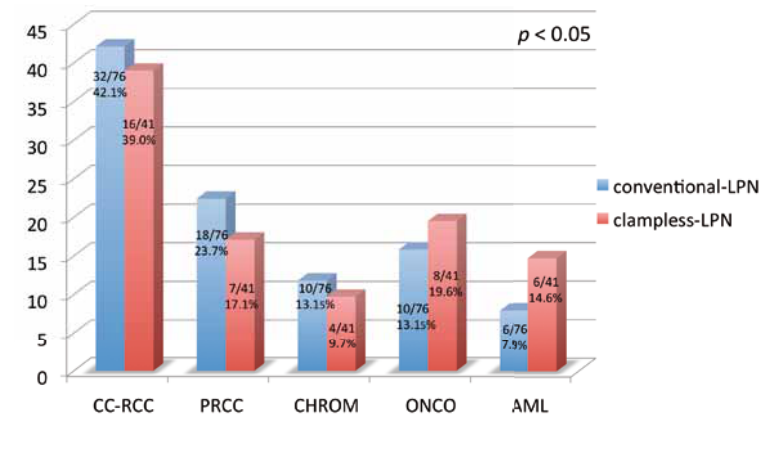
Figure 2 - Histogram showing histotypes’ distribution at histopatological analysis. In Red color: clampless LPN; in Blue color: conventional LPN (cc-Rcc: clear-cell renal cell carcinoma; PRcc: papillary cell renal cell carcinoma; cHROM: chromophobe renal cell carcinoma; ONcO: renal oncocytomas; AML: renal angiomyolipomas).